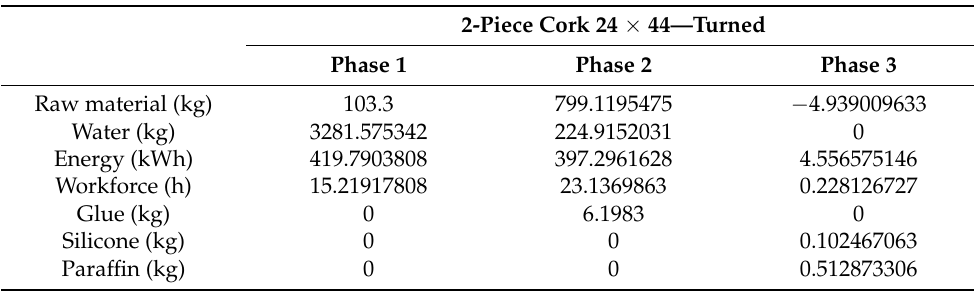
Table 3. Consumptions for 1000 kg raw material used to produce 2-piece stoppers with dimensions of 24 × 44—Turning method.